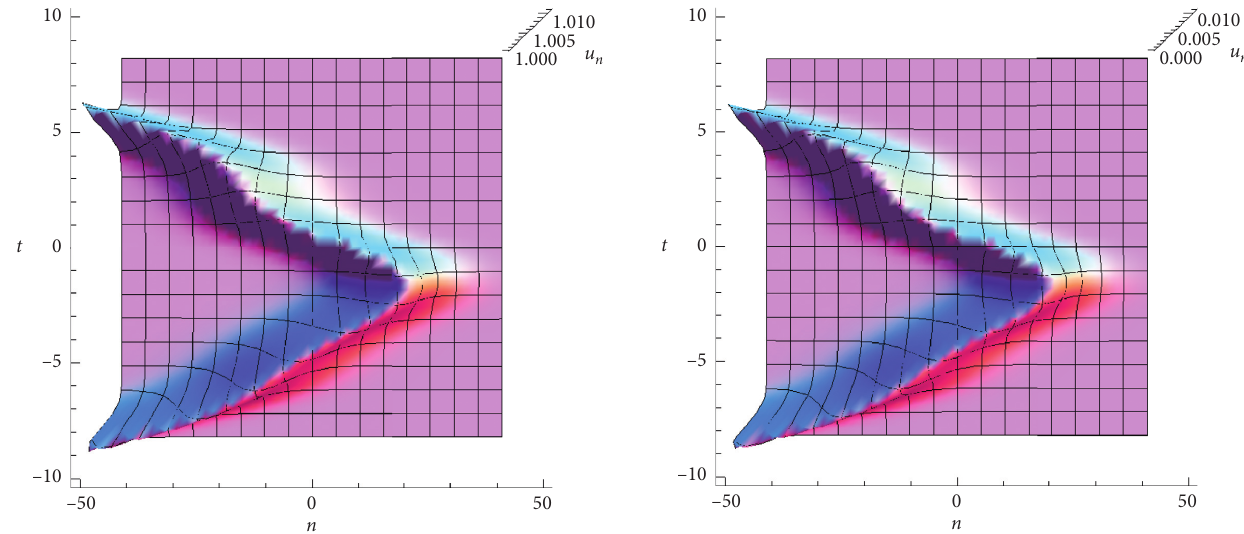
Figure 2: Spatiotemporal structure of semidiscrete one-soliton solution (70) with the parameters α � sech t , c ( 0 ) � 1, k � 3, and z α 3 1